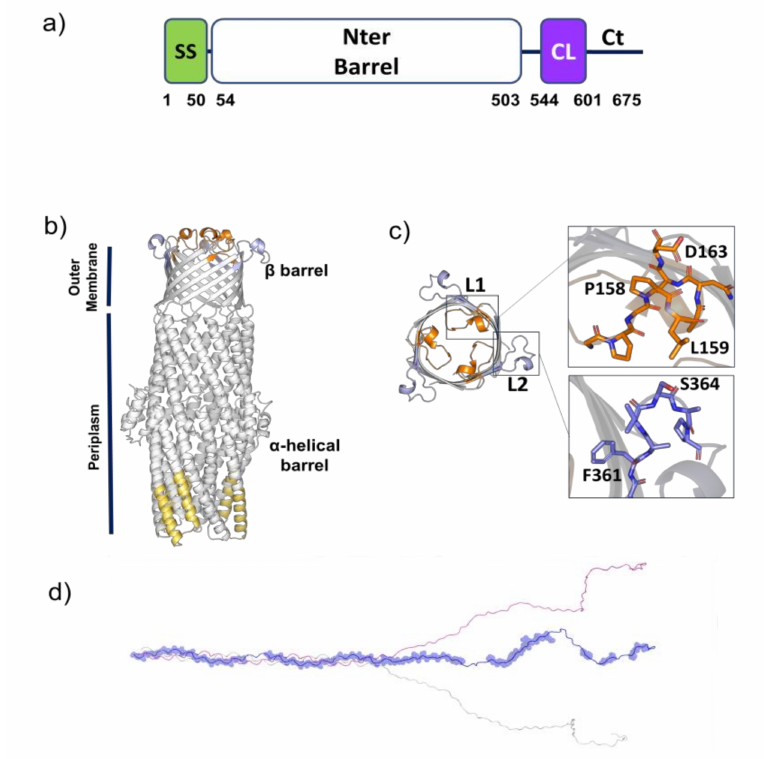
Figure 2. A structural view of Bucl8 ( a ) Domain borders of Bucl8. Numbers indicate position in amino acid sequence. SS, signal sequence; Nter, N-terminal; CL, collagen-like; Ct, C-terminal. ( b ) Cartoon representation of the homology model of Bucl8 N-terminal barrel domain, including a periplasmic α -helical barrel domain and a transmembrane β -barrel domain. Predicted structure- based antigens are shown in yellow on the α -helical barrel domain, and in orange and light blue on the β -barrel domain. ( c ) Top view of the transmembrane β -barrel domain of Bucl8. The two insets show enlargements of the L1 (orange) and L2 (light blue) peptides. ( d ) Cartoon representation of the model of the CL-Ct region of Bucl8. BepiPred predicted sequence-based antigens are drawn in one monomer as transparent spheres. Table 3. Structure based predicted B cell epitopes of Bucl8, computed using ElliPro. Peptide